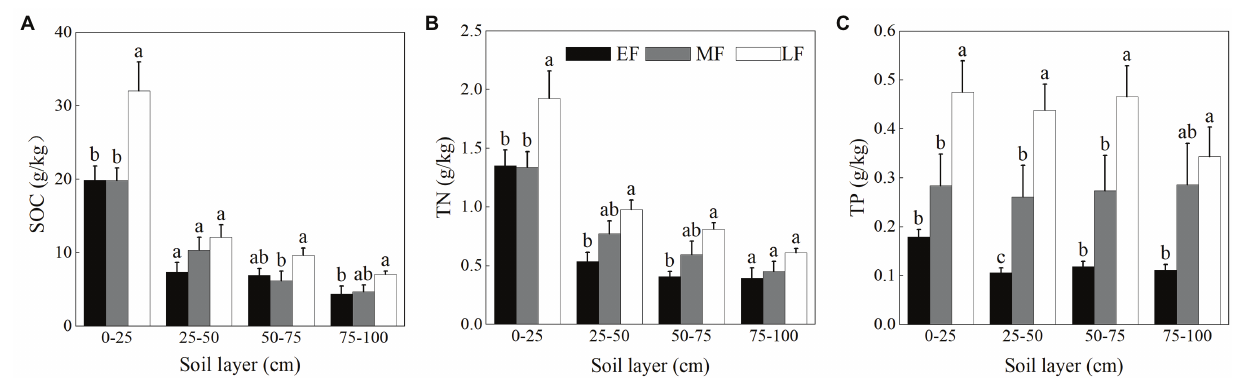
Figure 2C , the variation of the TP content in the vertical